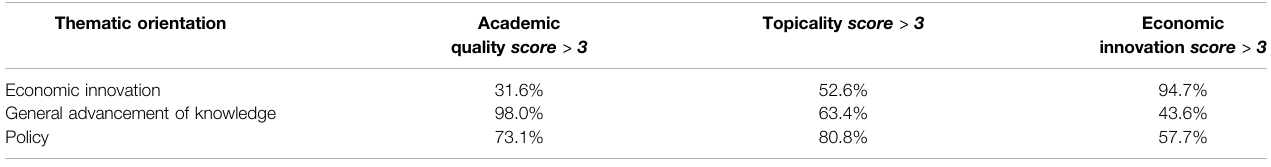
TABLE 2 | Importance of assessment criteria (score > 3) by formal orientation of the instrument. Note: NL instruments and 1 DE instrument have some missing data on assessment criteria. Thematic orientation